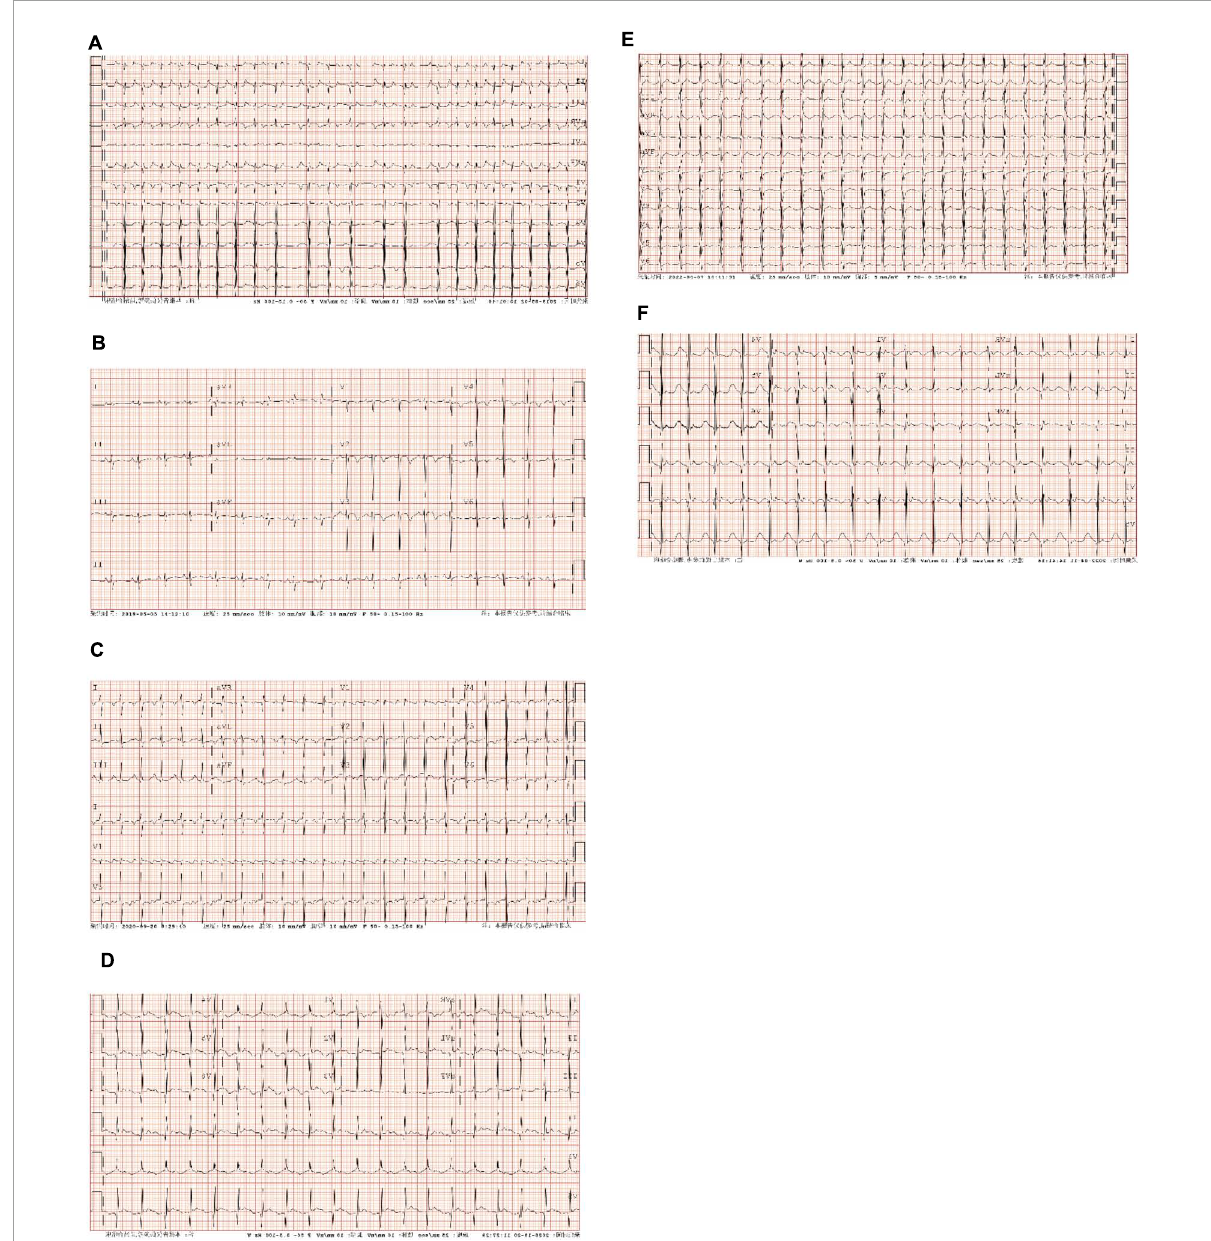
FIGURE1 Preoperative and postoperative electrocardiographic (ECG) of atrial tachycardia (AT) from atrial appendage (AA). (A) Case 1: persistent AT. The ventricular rate was 137–200 bpm; P waves in lead V1 were negative, and P waves in V3–V6 gradually moved in the positive direction; P waves in leads I, II, III, and aVF were positive, and P waves in lead aVL were negative; the PR interval was prolonged, with no QRS wave after partial P wave. (B) Case 1: ECG after radiofrequency catheter ablation (RFCA). Sinus rhythm; P waves in leads I, II, III, aVF, and V1–V6 were positive, and the HR was 110 bpm. (C) Case 2: persistent AT. The ventricular rate was 142 bpm; P waves in lead V1 were positive and bimodal; P waves in leads II, III, and aVF were positive; P waves in leads I and aVL were negative. (D) Case 2: ECG after left atrial appendage (LAA) resection. sinus rhythm; P waves in leads I and aVL were positive, and the HR was 120 bpm. (E) Case 3: persistent AT. The ventricular rate was 145 bpm; P waves in lead V1 were negative, and P waves in leads V2–V6 gradually moved in the positive direction; P waves in leads I, II, III, aVF, and aVL were positive; the PR interval was prolonged. (F) Case 3: ECG after RAA resection. Sinus rhythm; P waves in leads I, II, III, aVF, and V1–V6 were positive, and the HR was 108 bpm. AT, atrial tachycardia; bpm, beats per minute; RFCA, radiofrequency catheter ablation; ECG, electrocardiogram; LAA, left atrial appendage; RAA, right atrial appendage; HR, heart